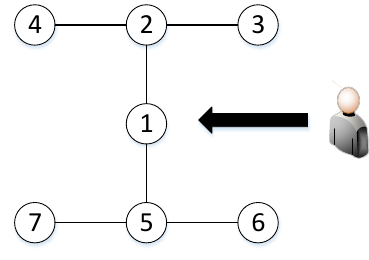
Figure 1. Network